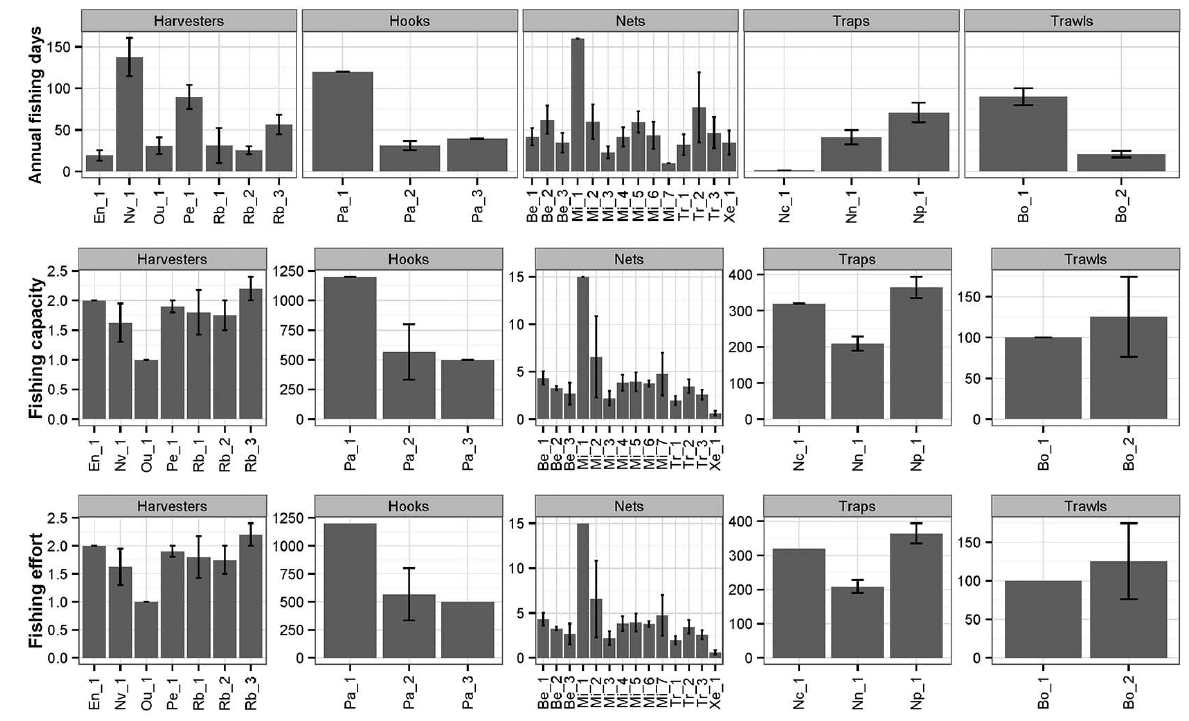
Fig. 6. – Mean (±SE) of the number of annual fishing days, fishing capacity, and the annual fishing effort (FE in the Cíes Islands using the different fishing strategies. Fishing capacity was measured as number of harvesters (for S-fisheries), number of hooks (for longlines), length of net in km (for gillnets and trammel nets), number of pots (for trap gears), and length of the wing net in m (for trawl gears). FE was estimated as the product of fishing days and fishing 2